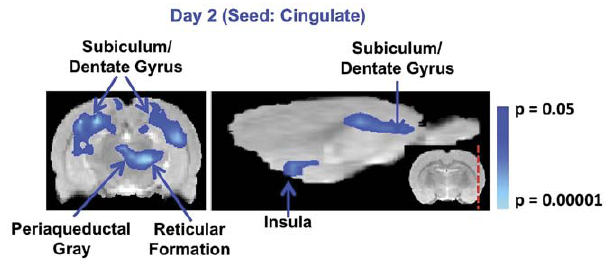
Figure 4. At Day 2, the within group, functional connectivity analysis demonstrated a significant de-coherence between the cingulate and insula cortex as well as the hippocampal formation (dentate gyrus, subiculum) and periaqueductal gray. Significant de-coherences between the cingulate and compo- nents of the task positive network such as the motor cortex were not observed.